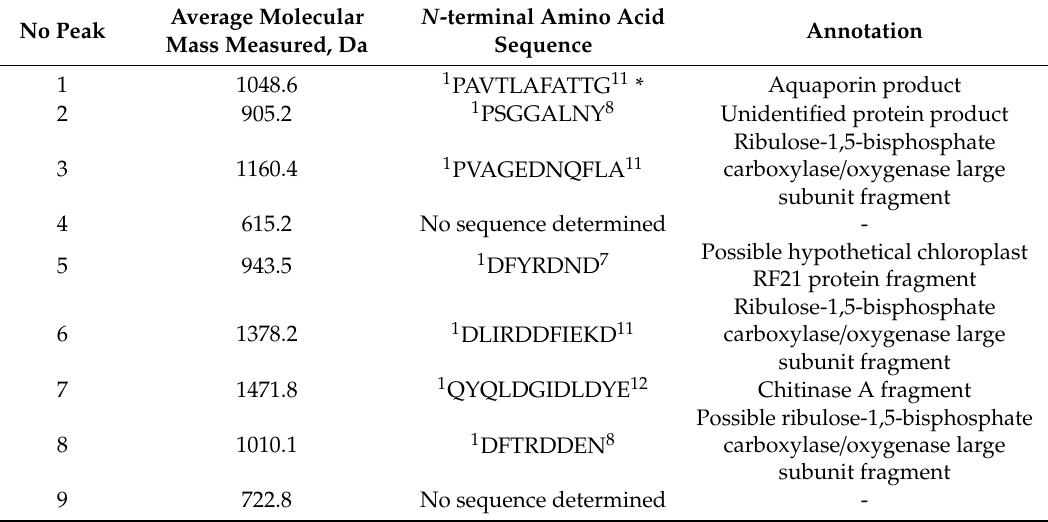
Table 2. A list of peptides identified in the extract from common horsetail ( E. arvense